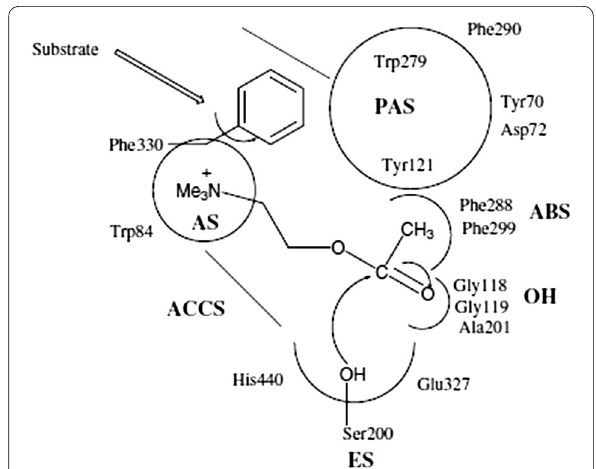
Fig. 13 Active site and PAS of AChE. Numbers refer to residue positions in Torpedo California AChE